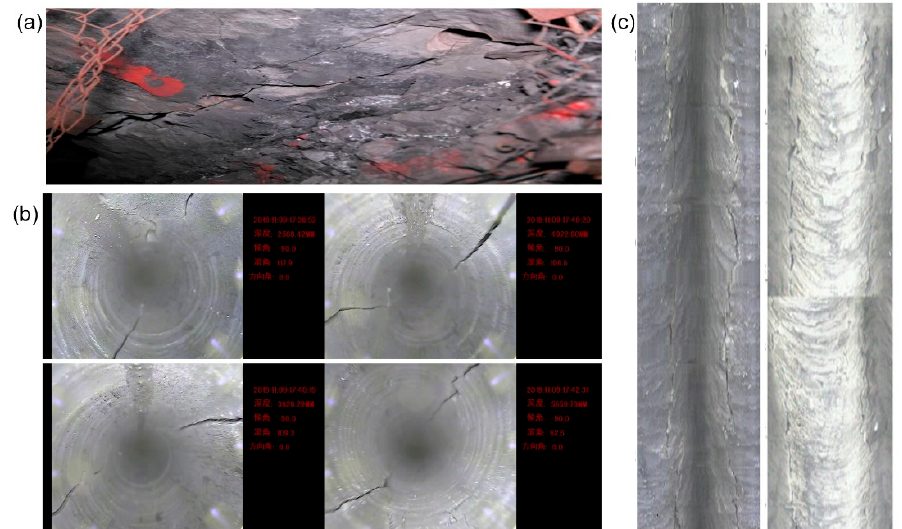
Figure 10. Roof-Cut presplitting blasting ( a ) A crack is formed on the surface of the roof ( b ) Cracks viewed from the inside of the hole ( c ) An expanded graph of cracks viewed from the inside of the hole.